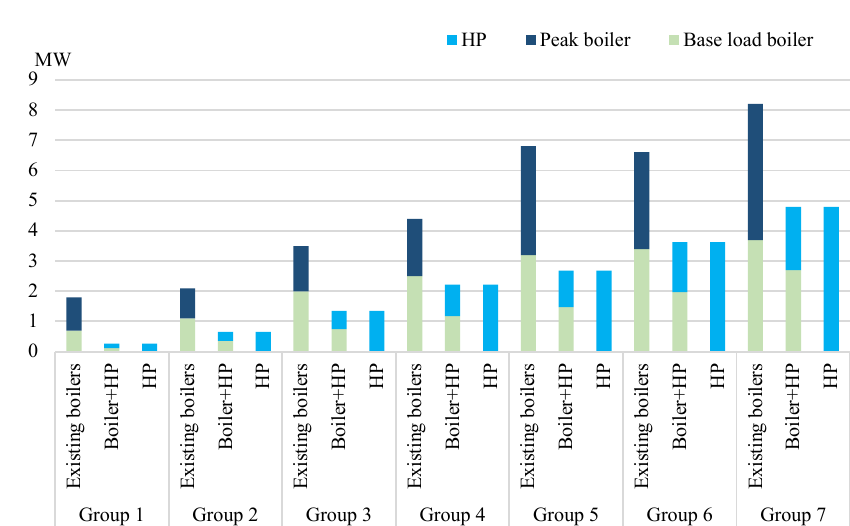
Fig. 3. Existing boiler capacities and capacity estimates for each